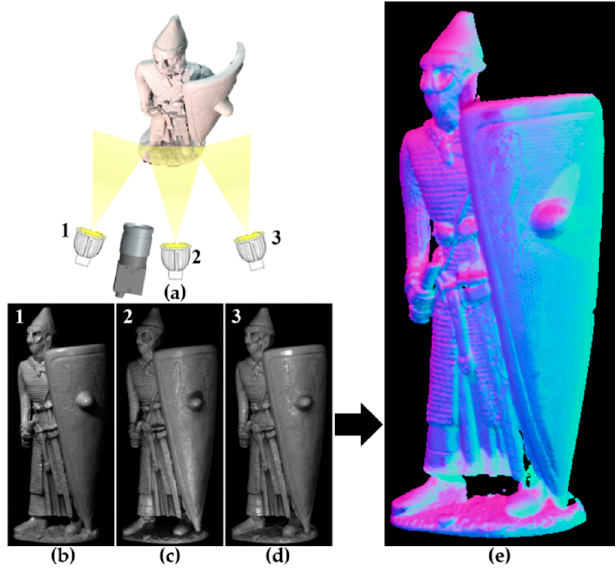
Figure 2. ( a ) Our photometric stereo system configuration; ( b – d ) Images taken under different positions of external light source; ( e ) Acquired Normal map.